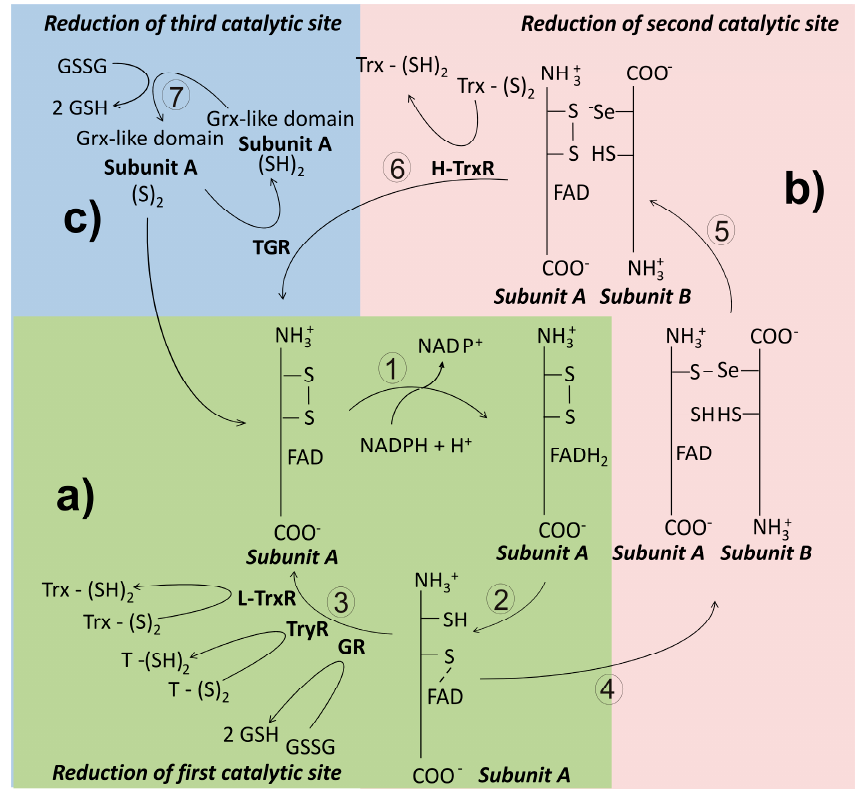
Figure 6 . General catalytic mechanism of disulfide reductase enzymes in invertebrate parasites. In panel ( a ) a simplified pathway for electron transfer from NADPH to a disulfide substrate is shown. This route is present in enzymes such as glutathione reductase (GR), trypanothione reductase (TryR), and the low-molecular weight thioredoxin reductase (L-TrxR). Panel ( b ) shows the additional reactions involved in the disulfide reduction followed by the high-molecular weight thioredoxin-reductase (H-TrxR). In panel ( c ) the additional pathway for electron transfer found in thioredoxin-glutathione reductase (TGR) is shown.